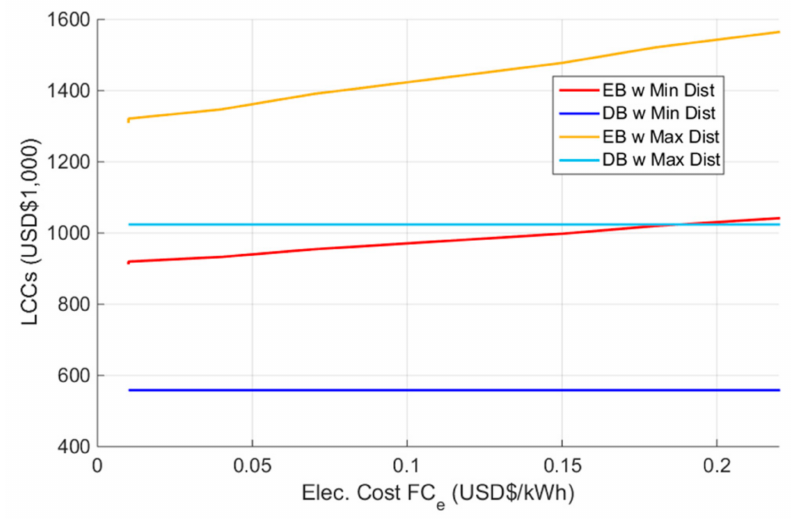
Figure 10. LCCs of electric and diesel buses, against the varying electricity cost for diesel prices at the current subsidized rate of USD$0.23/L.